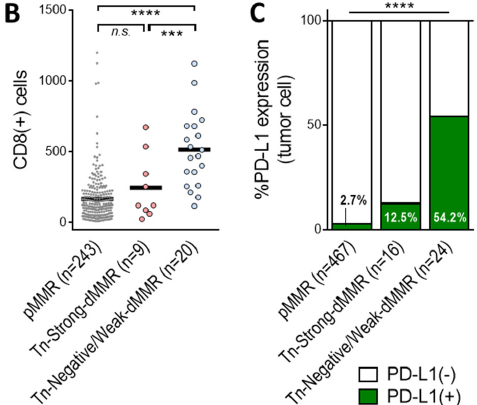
Figure 2. The Tn-strong dMMR subset lacks common immunological characteristics of dMMR tumors, including CD8 + T cell infiltration and tumor cell surface PD-L1 expression. ( A ) Representative immunohistochemistry images for Tn antigen, CD8, and PD-L1 in pMMR, Tn-strong dMMR, and Tn-negative / weak dMMR tumors. ( B , C ) Tn-strong dMMR tumors displaying lower levels of CD8 + T cell infiltration ( B ) and PD-L1 expression ( C ), compared to those of Tn-negative / weak dMMR tumors. **** p < 0.0001, *** p < 0.001, n.s. p > 0.05.